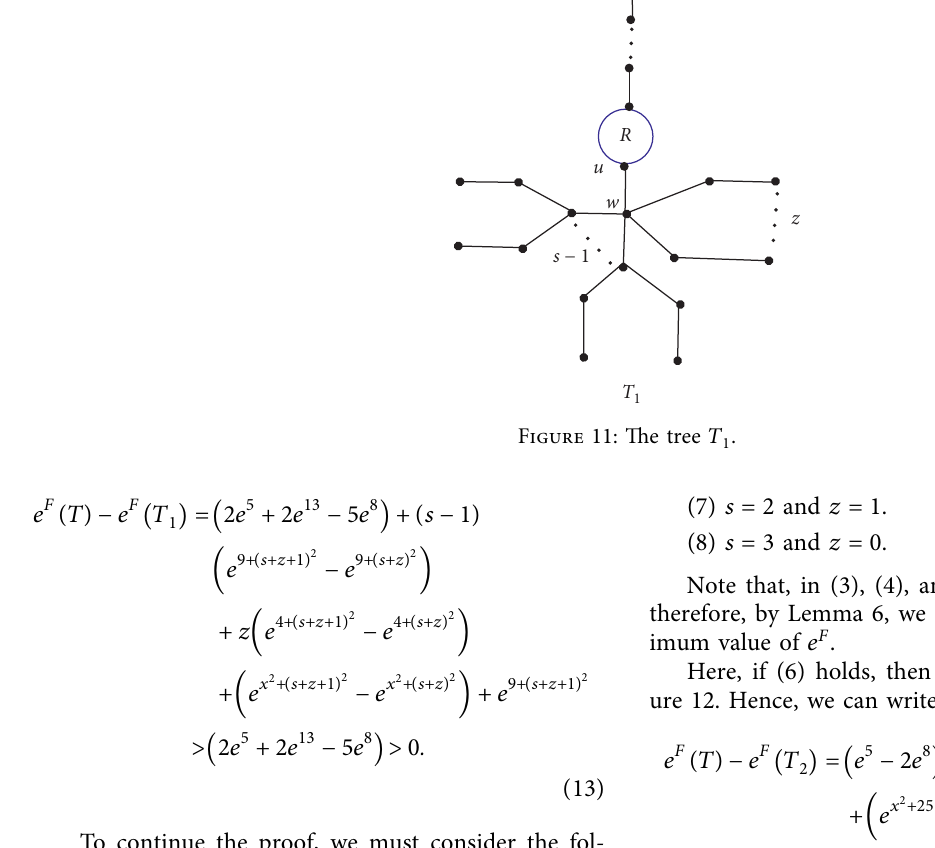
Figure 10: The tree T .